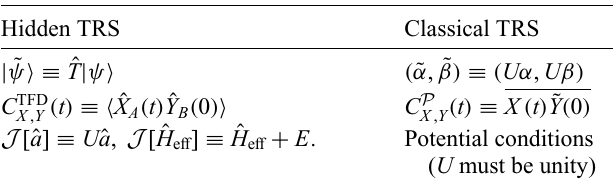
tions via quantum detailed balance (i.e., hidden TRS), and their counterparts in the language of classical detailed balance in the